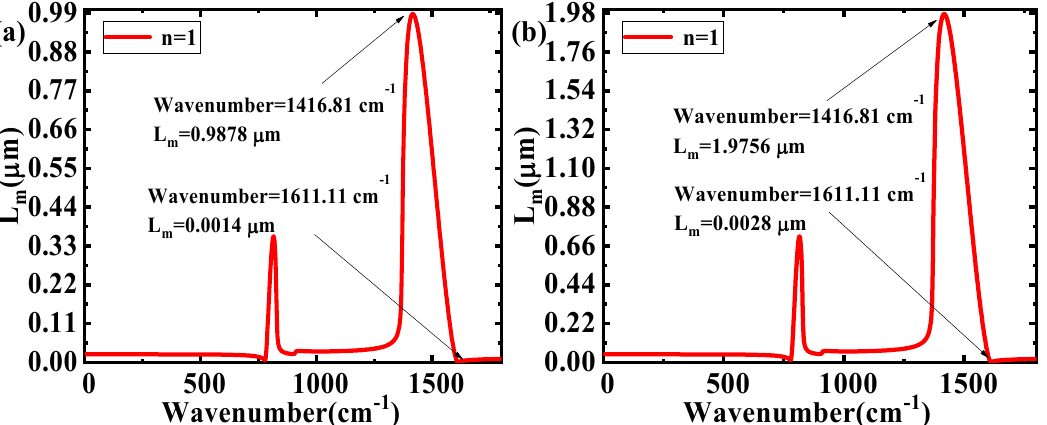
Figure 7. L m as a function of wavenumber in different thicknesses of h ‐ BN: ( a ) ε 1 = 1, ε 2 = 3.9, d = 50 nm; and ( b ) ε 1 = 1, ε 2 = 3.9, d = 100 nm.